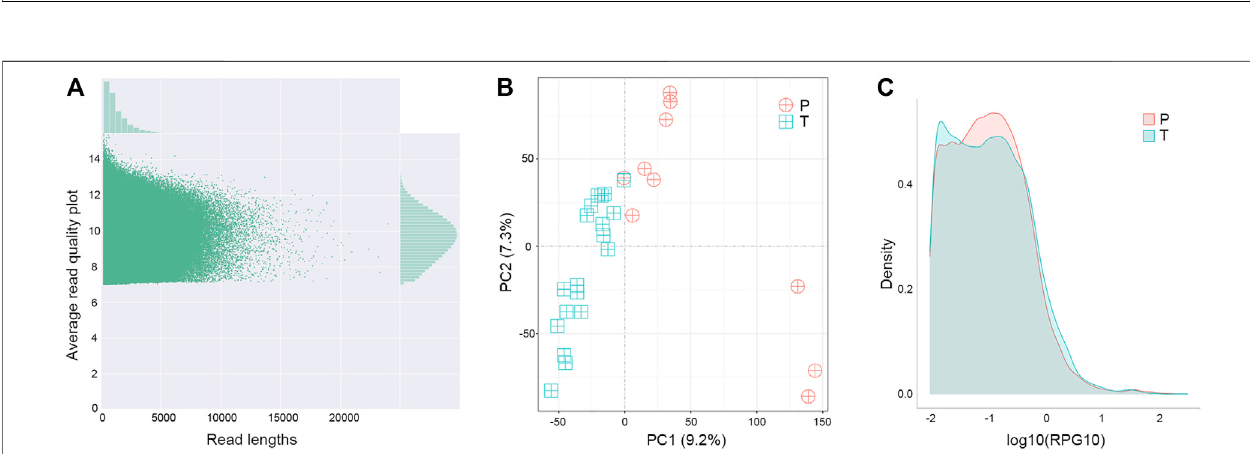
FIGURE6| Distinguishable transcriptomes oftumor samplesfrom othersin long-read sequence. (A) Qualitycontrol oftranscriptomeanalysis. Transcriptomewas built-up based on their cDNA library construction followed by ONT nanopore sequencing. Plot showed the quality of individual data points (main fi gure) as well as their distributions(topand leftinsets).Datapointsbelow7inAverage ReadQuality(i.e.,lowerthan85%accuracyfrom ONTmanual instruction) wereexcludedfromanalysis. (B) Principal component (PC) analyses. Each symbol represented one clinical sample from para-tumor tissues (P) and tumor tissues (T). Clearly the majority of samples were quite distinguishable from ones from the other group. (C) Density ofreads per gene10(RPG10K) plot. Differential patterns from different types of samples revealed that tumor tissues had smaller reads per genes than para-tumor tissues.